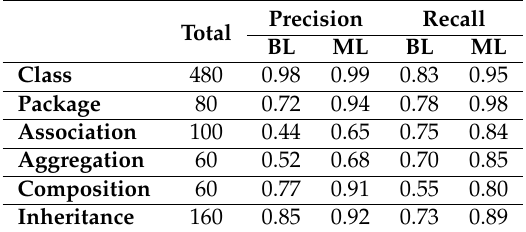
Table 4. Recognition rates by